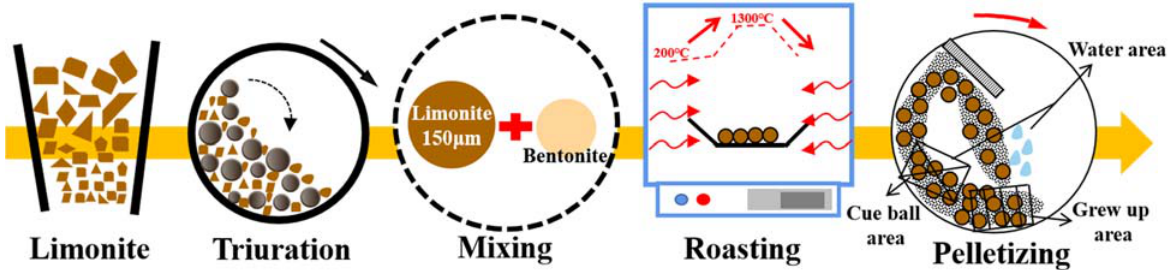
Figure 1. Limonite pellet ‐ roasting process.